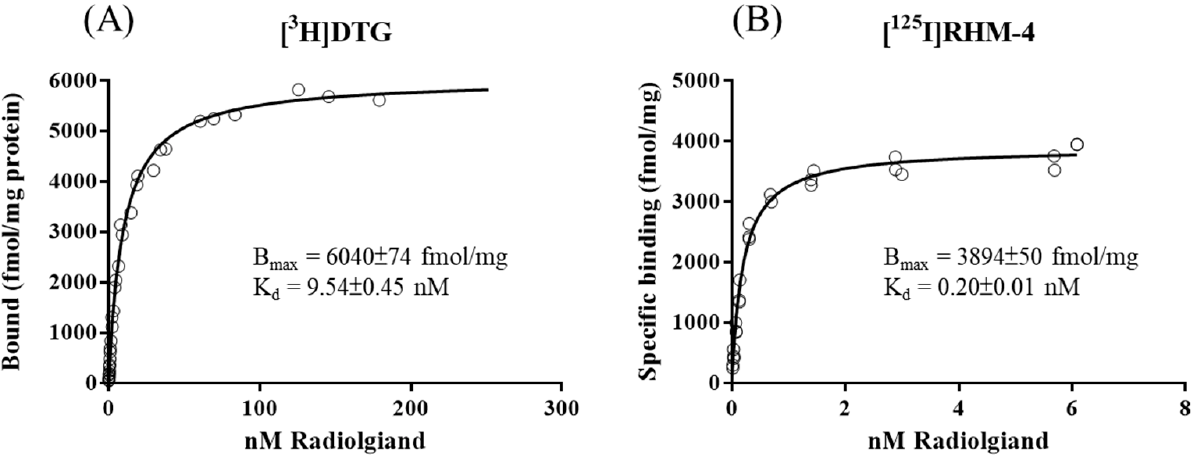
Figure 1. Saturation binding curves of [ 3 H]DTG ( A ) and [ 125 I]RHM-4 ( B ) on SD rat liver membranes. Both groups were performed with n = 3.